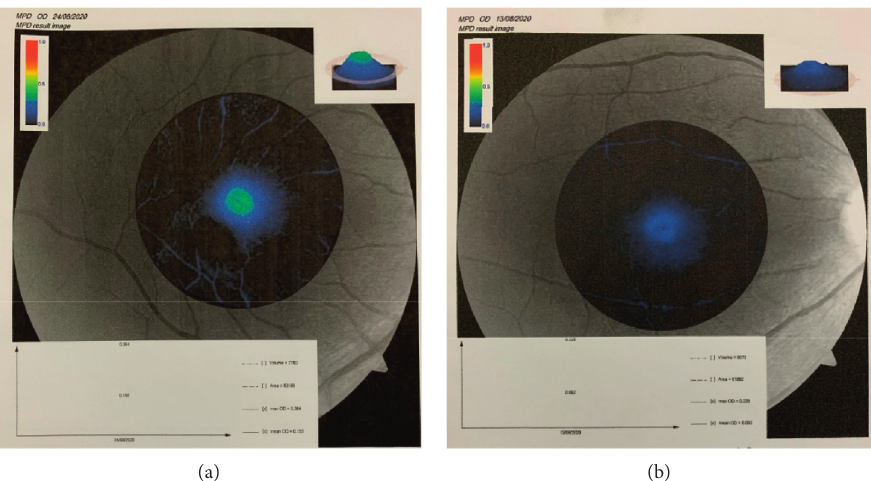
Figure 1: Comparison of the right eye of 2 participants with different MPOD values, analyzed by VISUCAM 500. (a) Participant with high MPOD, coded green-yellow (mean MPOD of the right eye � 0.155 density unit) and (b) participant with low MPOD, coded blue (mean MPOD of the right eye � 0.082 density